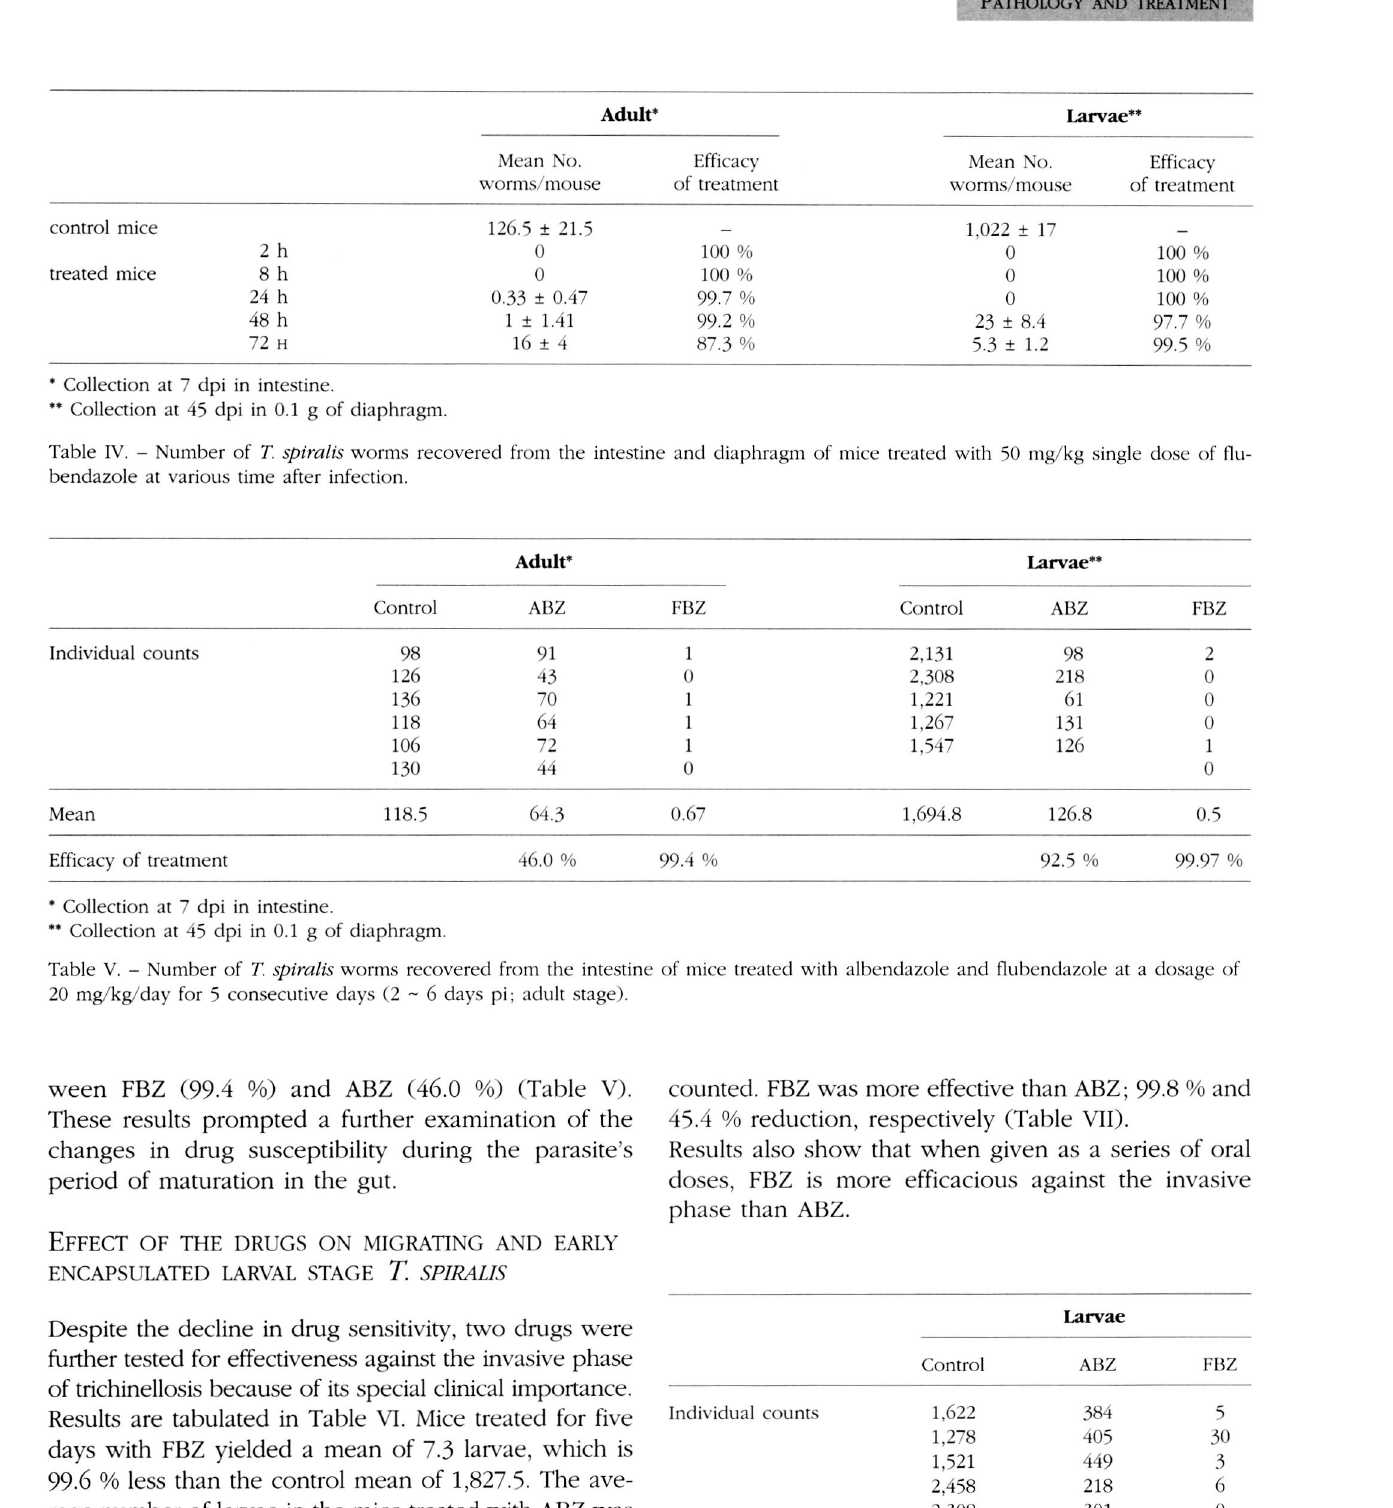
ween FBZ (99.4 %) and ABZ (46.0 %) (Table V).